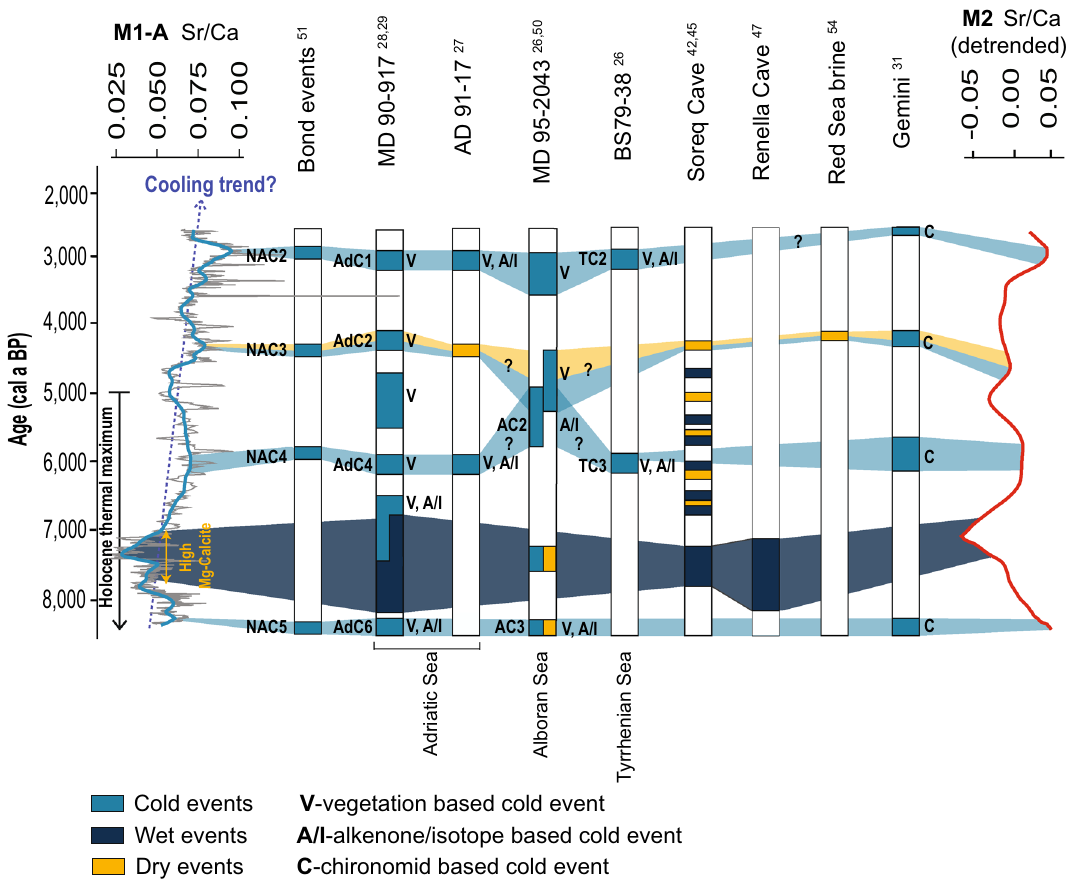
Figure 3. Sr/Ca records for Cores M1 and M2 as indicators of relative paleotemperature and paleohydrology compared to paleotemperature and paleohydrological proxies from other records from the wider Mediterranean region. The Mg-calcite-rich interval is underlain by a dark blue area in the Sr/Ca record. Otherwise, needle-like aragonite is the dominant phase. NAC, AdC, AC, and TC are abbreviations for cold events based on the original